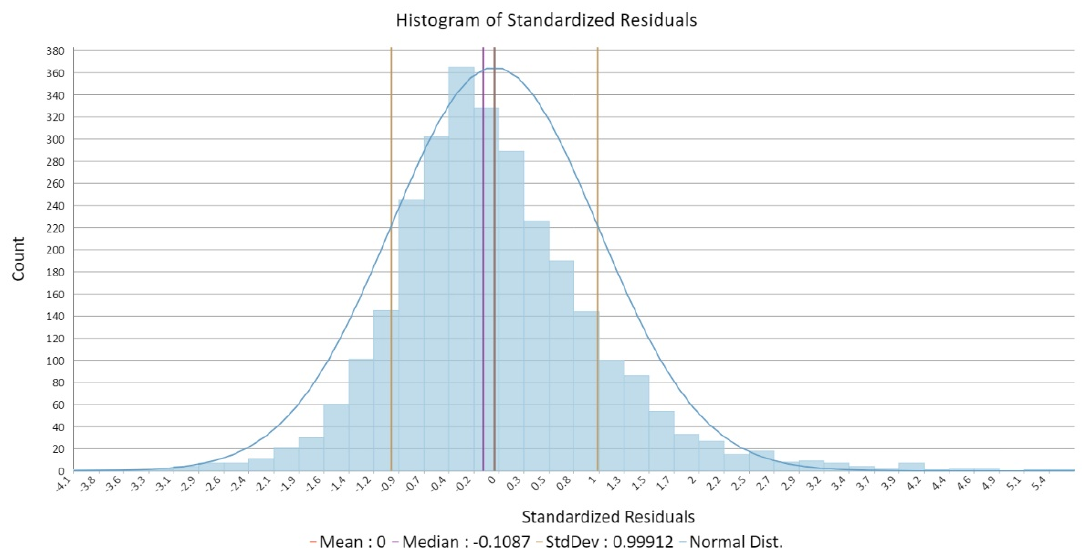
Figure 7. Histogram of the OLS standardized residuals.